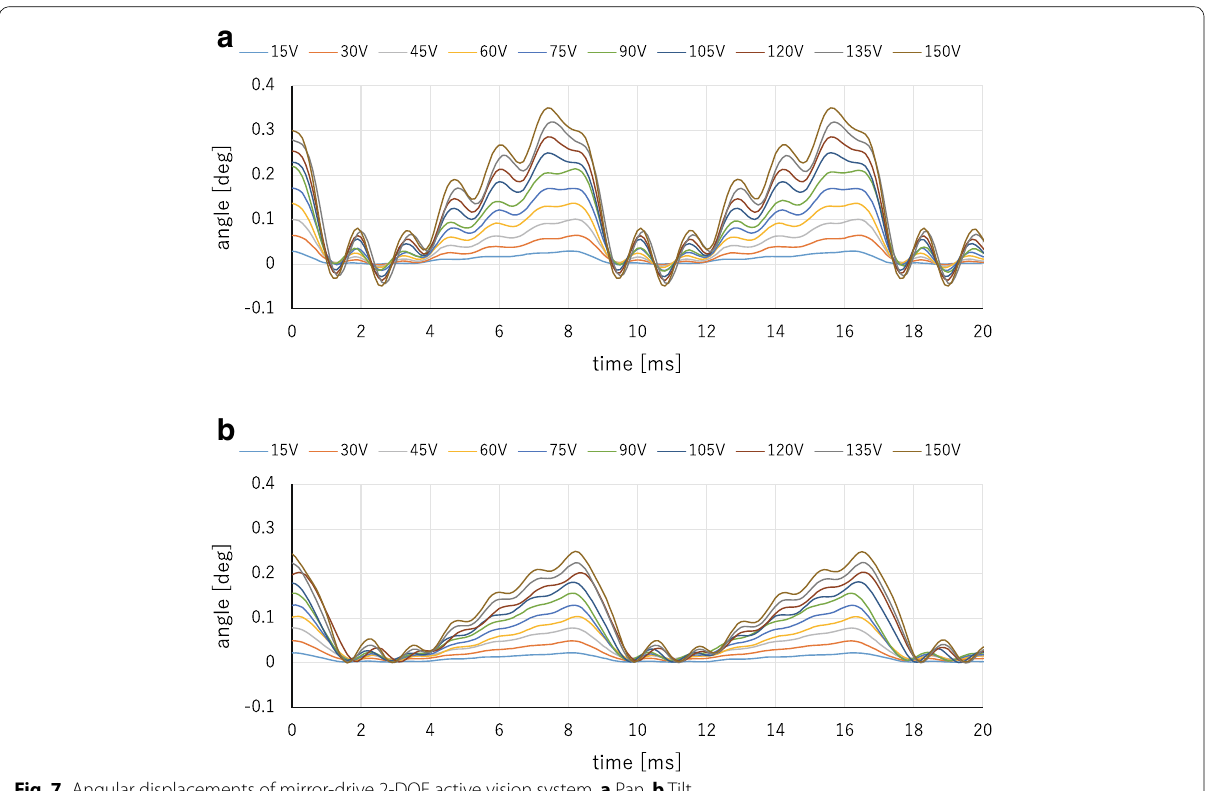
Fig. 7 Angular displacements of mirror-drive 2-DOF active vision system. a Pan. b